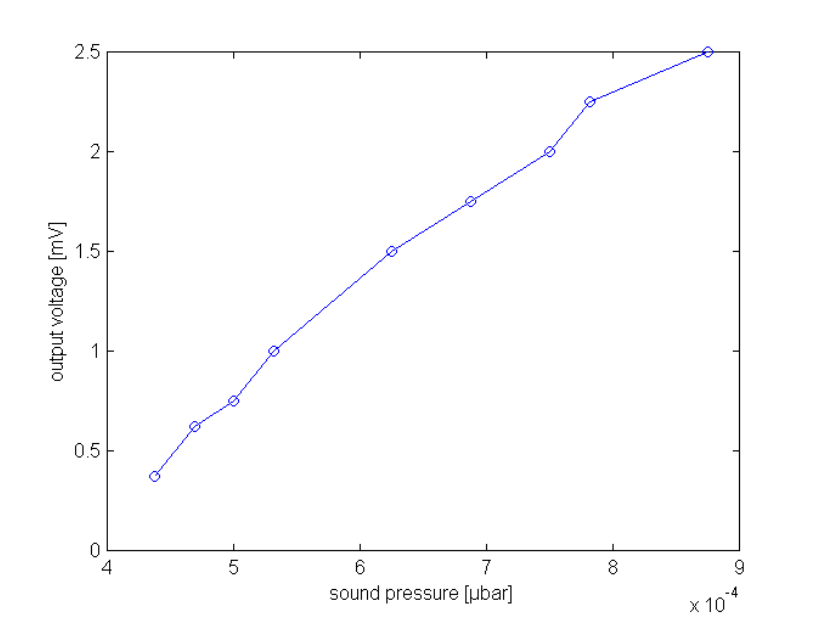
Figure 13. Sound pressure sensitivity of a tested mechanical element.